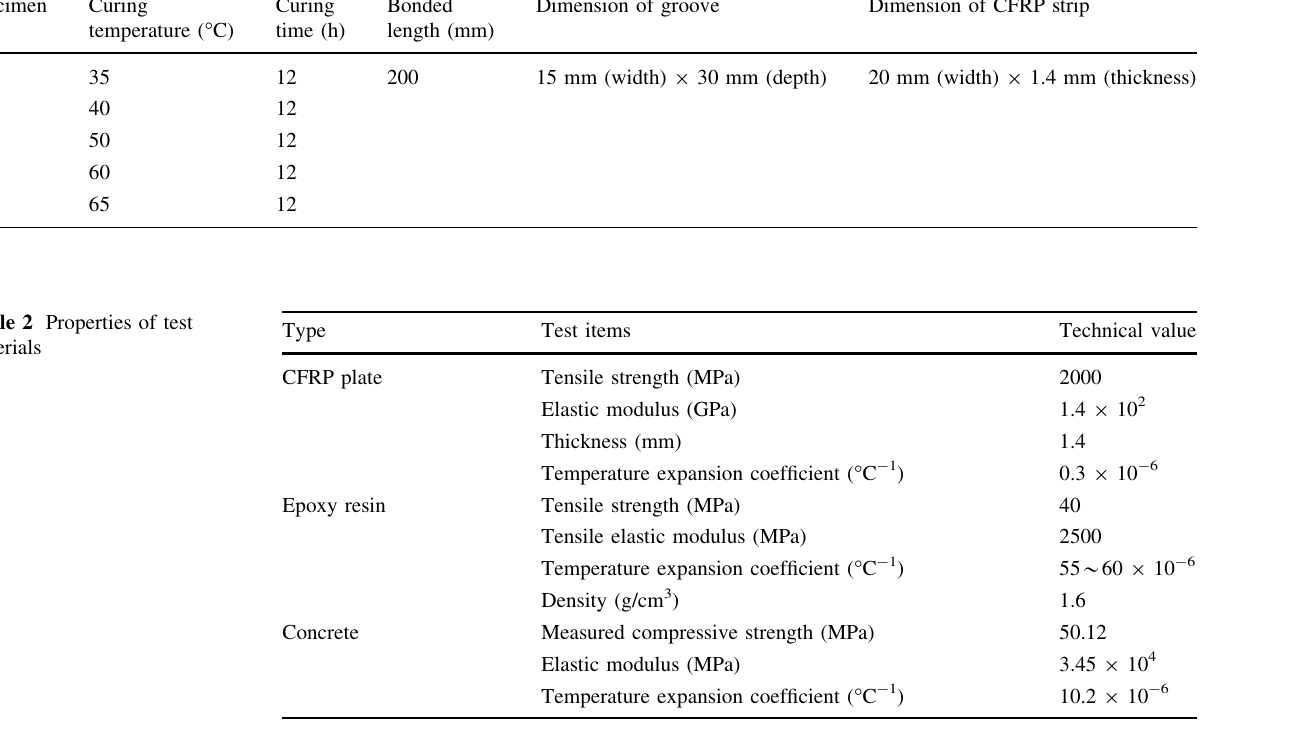
Table 1 Test plan of NSM CFRP strip at different curing temperatures Specimen ID